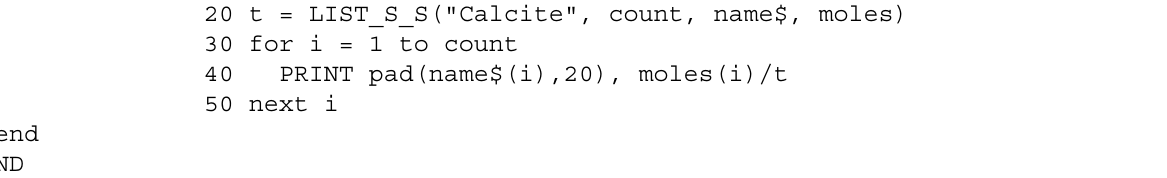
Table 57. Input file for example